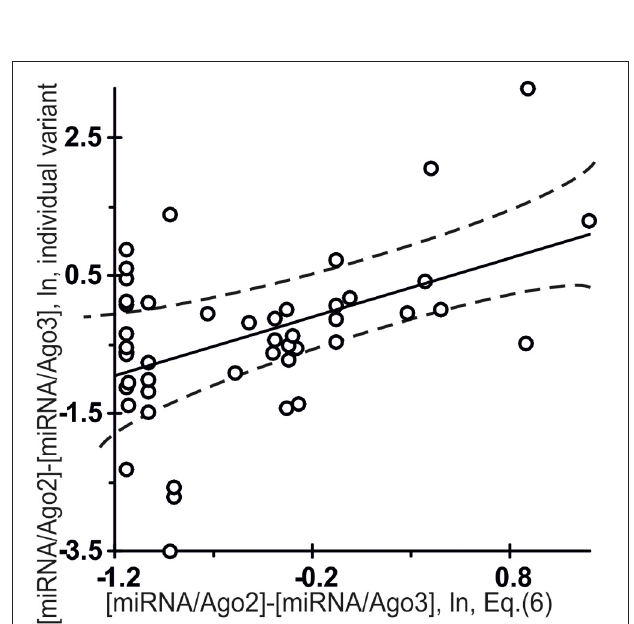
FIGURE 7 | Control test for the difference between the affinity of miRNAs for Ago2 and that for Ago3 (Equation (6), the x -axis) estimated using final Equation (5) and independent experimental data (the y -axis) on the miRNA individual variants taken from the same data source (Azuma-Mukai et al., 2008). The differential affinities of the Ago2 and Ago3 proteins for 48 miRNAs named the “individual variants” by Azuma-Mukai et al. (2008) because of their 5 (cid:2) - and/or 3 (cid:2) -terminal differences from canonical mature miRNAs, which were associated by Azuma-Mukai et al. (2008) with (i) alternative maturation (Azuma-Mukai et al., 2008) or (ii) post-maturation processing (Azuma-Mukai et al., 2008), as independently measured in vivo (Azuma-Mukai et al., 2008) and as estimated in silico [Equation (6)] and expressed in natural logarithms are statistically significantly correlated ( Table 4 ). Dashed curves and solid lines as in the legend to Figure 3